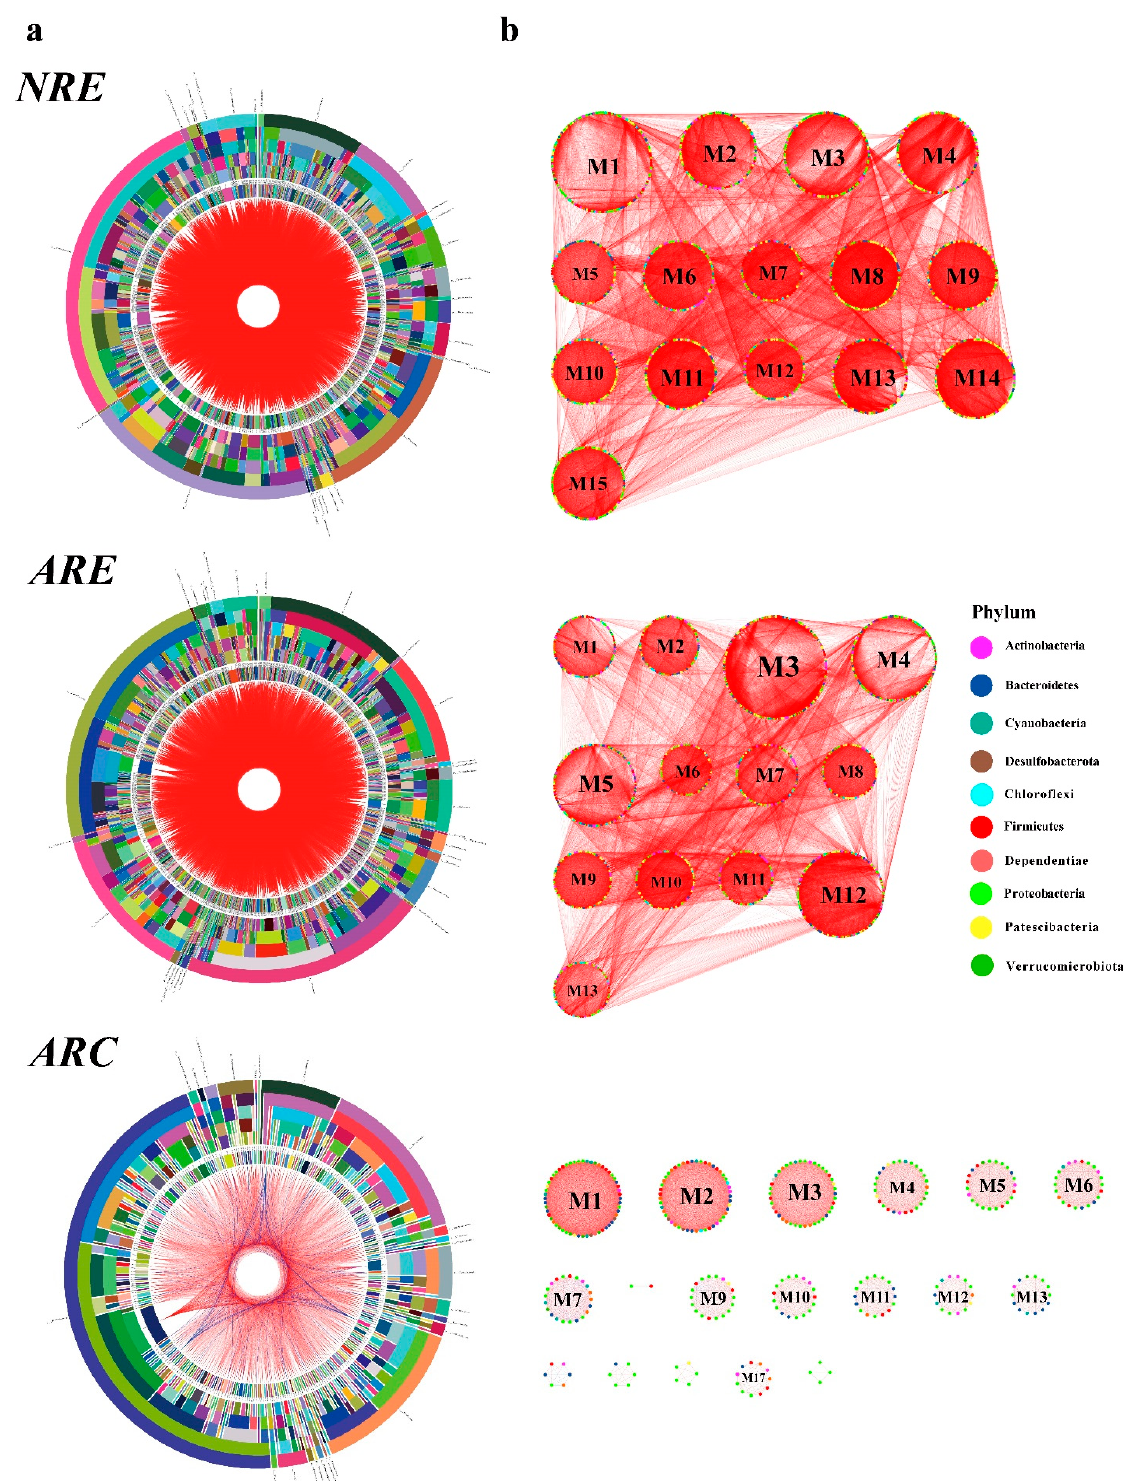
Figure 5. Microbial co-occurrence subnetworks and their modularity. ( a ) The taxonomic levels are class, order, family, genera, and species from the outside to the inside of the circle. ( b ) Nodes in the network indicate OTUs. Colors of the nodes indicate different major classes. The edges (blue edge = negative interaction, and red edge = positive interaction) inside the circle and ecological network represent the interactions between species.